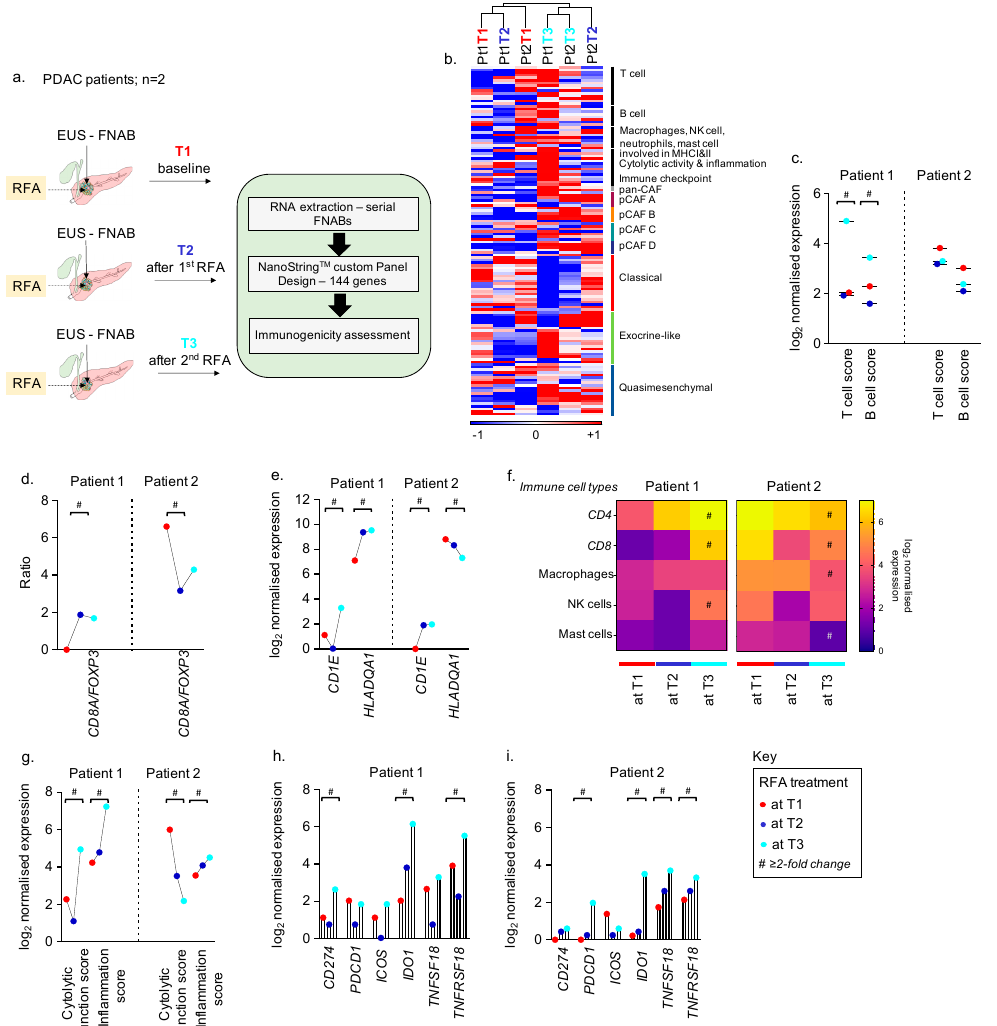
Figure 1. Longitudinal FNAB-based immunogenicity in PDAC patients treated with RFA. ( a ) Sche- matic illustration of longitudinal FNABs and RFA courses along with approaches used in this study. ( b ) Heatmap depicting distribution of genes across samples and grouped by unsupervised hierar- chical clustering. Scale bar indicates log 2 normalised expression ranging between -1 and +1. Colour bars represent appropriate CAF and PDAC subtype-specific colours. ( c ) Change in T and B cell scores at T1, T2 and T3 in patient 1 and 2, respectively. ( d ) Ratio of CD8A/FOXP3 in patient 1 and 2. ( e ) Change in expression of genes participating in antigen presentation via MHC-I and II at T1, T2 and T3 in patient 1 and 2, respectively. ( f ) Heatmap representing RFA-mediated regulation of genes associated with different immune cell types; single scale bar for both patients depicting log 2 normal- ised expression. ( g ) Change in tumour-immune response in pre- and post-RFA-treated FNABs measured as cytolytic function and inflammatory score. ( h , i ) Upregulation of immune checkpoint genes as a result of RFA in patient 1 and 2, respectively. # represents greater than or equal to two- fold change in gene expression between T1 and T3. Colour key represents T1 in red, T2 in blue, and T3 in cyan.